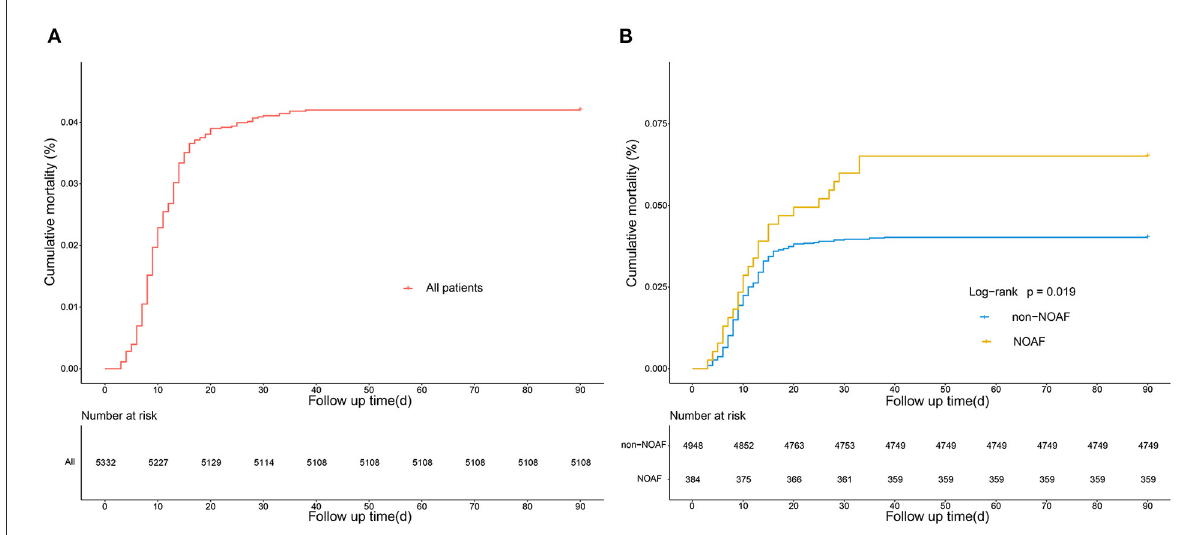
FIGURE9 Kaplan-Meier curves showing the cumulative mortality of all the patients of AFDAS (A) , and the comparison of cumulative mortality in patients with and without AFDAS (B) .